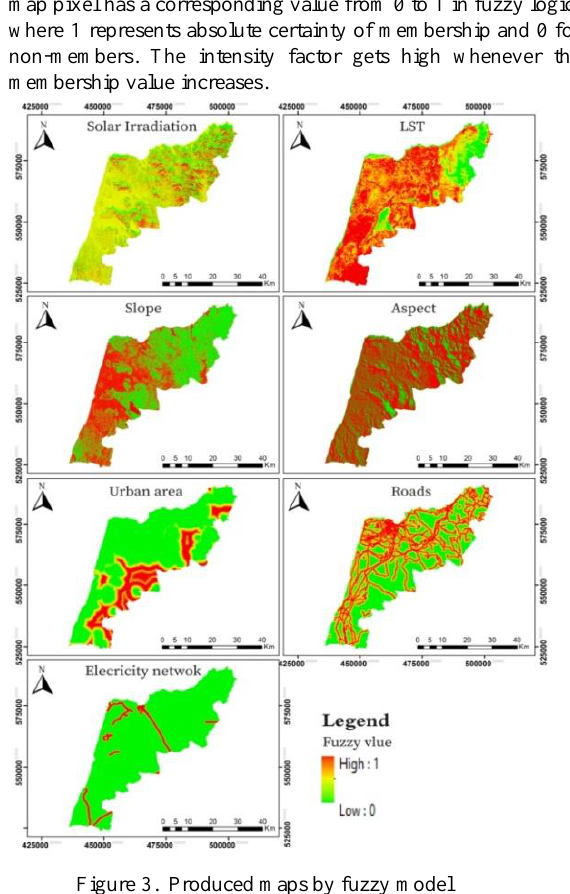
(Table 8) represents the solar electricity generation potential